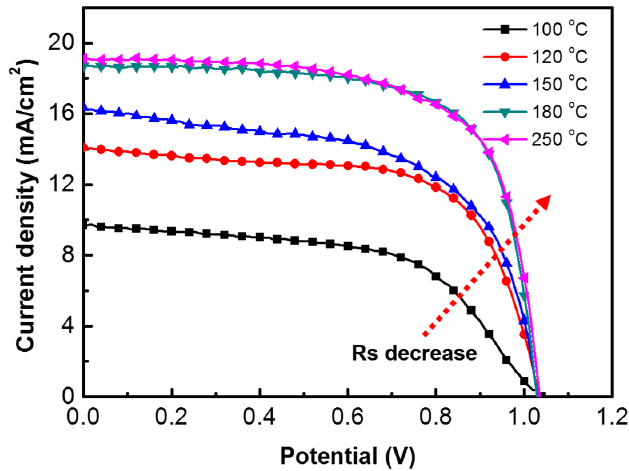
Figure 7. The J ‐ V curves of perovskite photovoltaic devices based on ZnO layer with different baking temperatures. Table 1. The photovoltaic performances and carrier lifetime of MAPbI 3 solar cell with different baking temperatures of the ZnO electron transport layer.